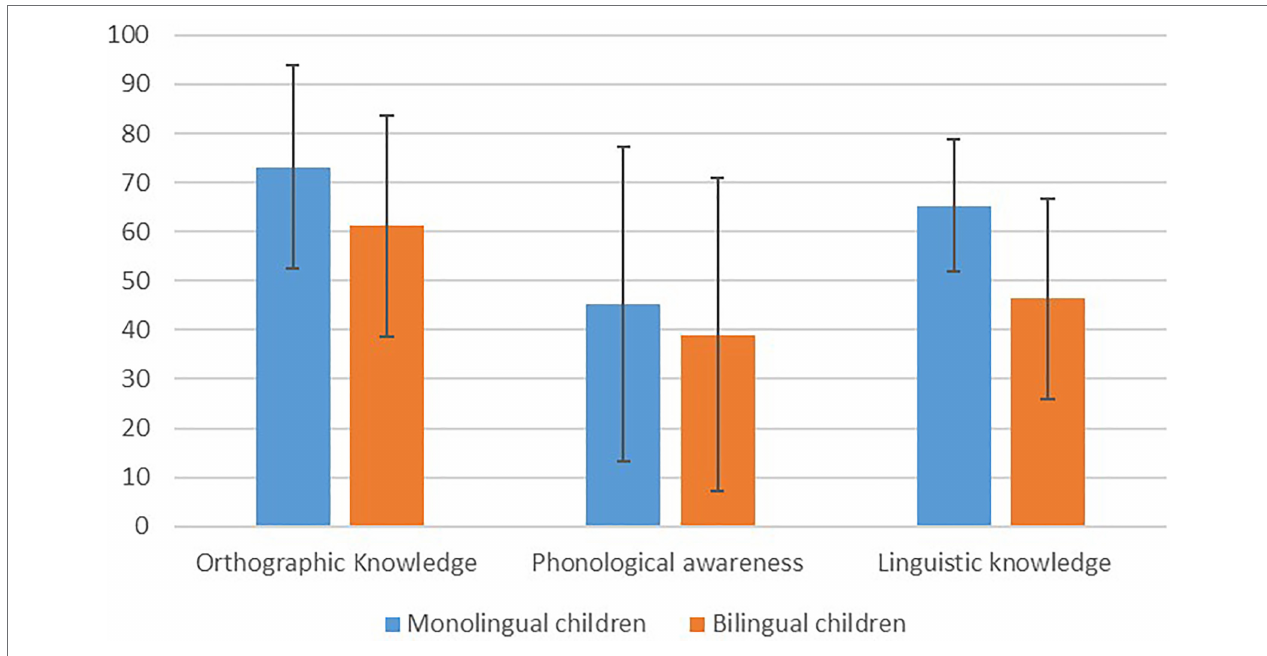
FIGURE 1 | The performance of monolingual and bilingual children on the different early literacy factors.